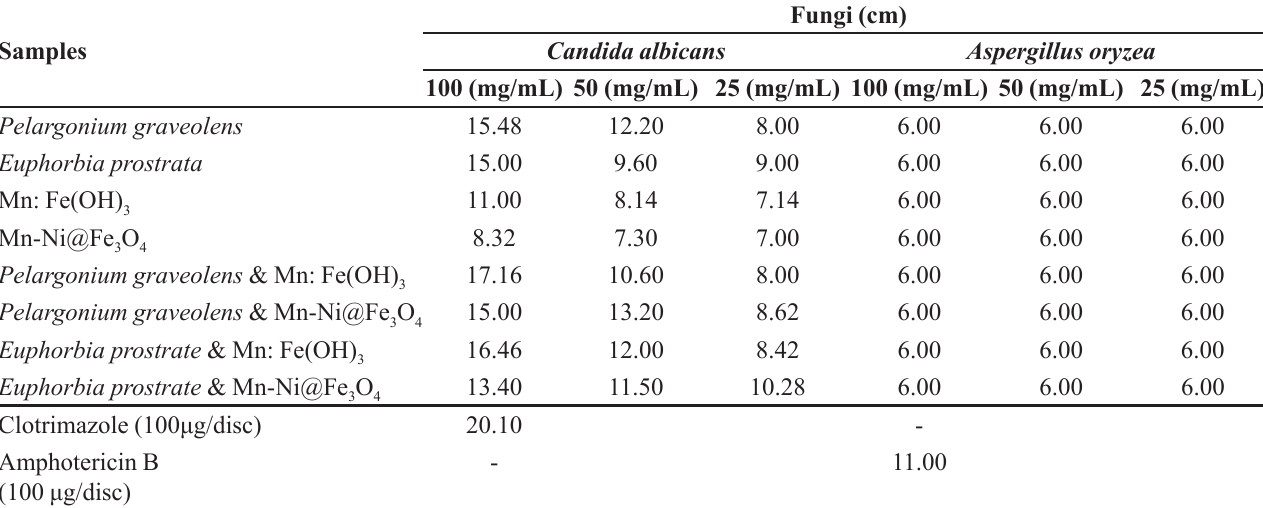
TABLE V - Antifungal activity as diameter of zone of inhibition ∗ (mm) around the constructed and standard discs. ∗ All data are the mean of three measurements